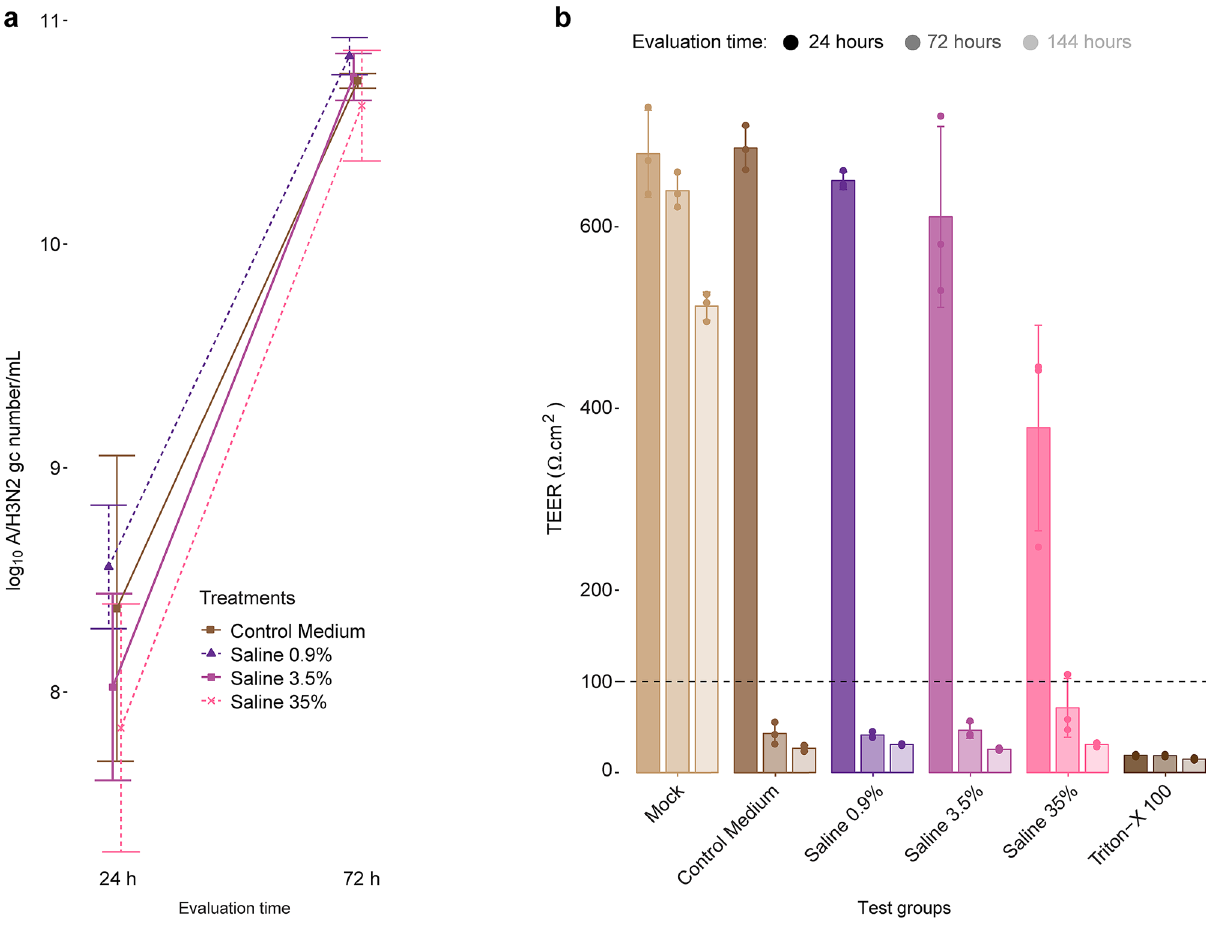
Figure 6. Effect of virus pre-incubation in hypertonic salt solutions on viral replication in cells. ( a ) TAQMAN reverse transcription-polymerase chain reaction for the determination of A/H3N2 virus genome copies (gc) in the apical medium of MUCILAIR epithelia infected after incubation of the virus in salt solutions of various concentrations. Data are expressed as log 10 A/H3N2 gc number/mL, quantified at 24 and 72 h post infection. Means ± standard errors are shown; n = 3. ( b ) Transepithelial electrical resistance (TEER) measurements in MUCILAIR epithelia 24, 72, and 144 h post infection. Means ± standard errors are shown; n = 3. The dotted line represents the 100 Ω·cm 2 limit of tissue integrity. Mock, non-infected non-treated control culture; Triton X-100, detergent used as a positive